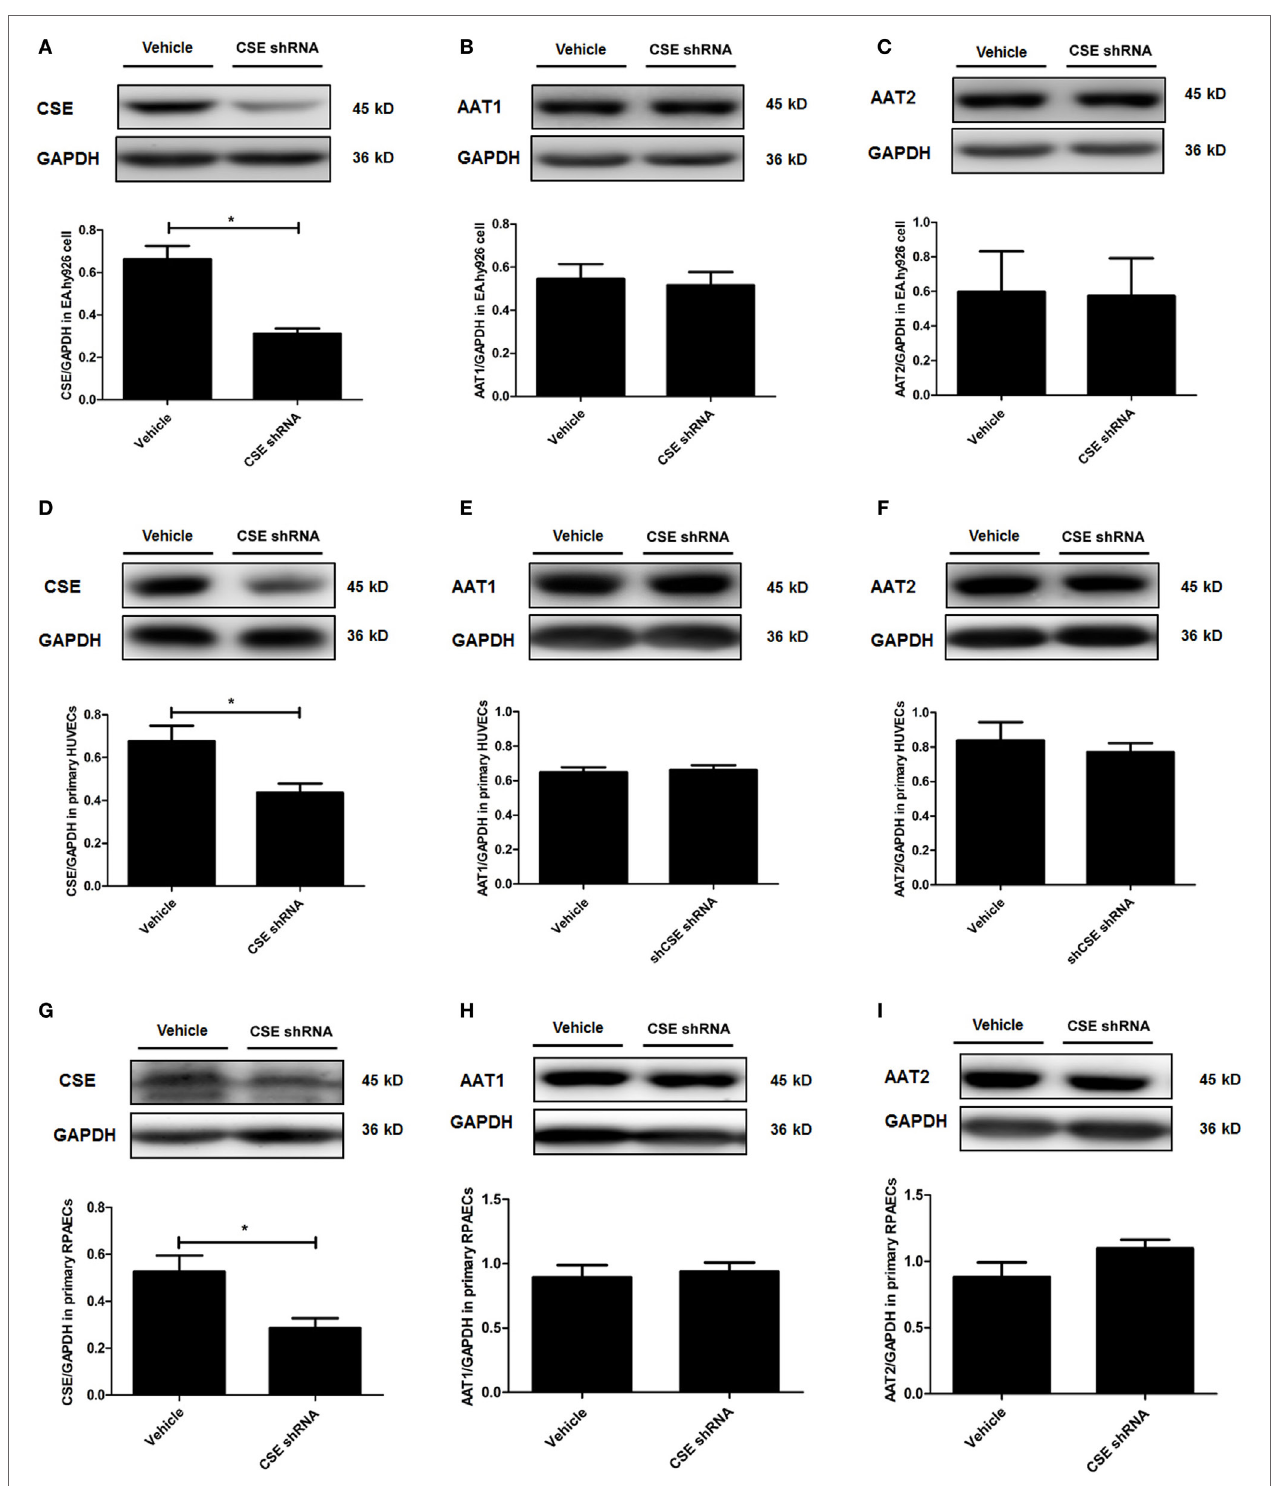
FigUre 2 | Cystathionine- γ -lyase (CSE) knockdown did not affect the expression of AAT1 and AAT2 in the endothelial cells. The EA.hy926 cells, primary human umbilical vein endothelial cells (HUVECs), and primary rat pulmonary artery endothelial cells (RPAECs) were transfected with vehicle lentivirus or lentivirus containing CSE shRNA. The expressions of CSE (a) , AAT1 (B) , and AAT2 (c) in the EA.hy926 cell were detected by western blot. The expressions of CSE (D) , AAT1 (e) , and AAT2 (F) in the primary HUVECs were detected by western blot. The expressions of CSE (g) , AAT1 (h) , and AAT2 (i) in the primary RPAECs were detected by western blot. * P < 0.05. Data are expressed as means ± SEM, and all experiments were performed independently for at least three times.